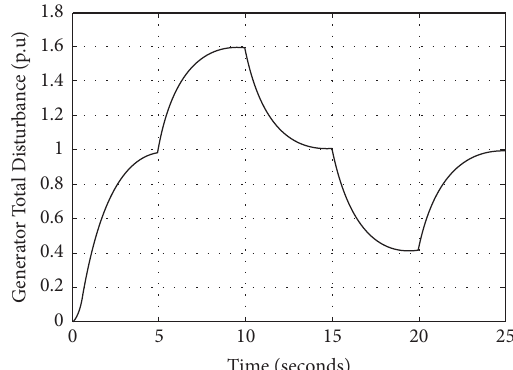
Figure 9: Estimation of generator total disturbance under − 50% parametric uncertainties in ( T